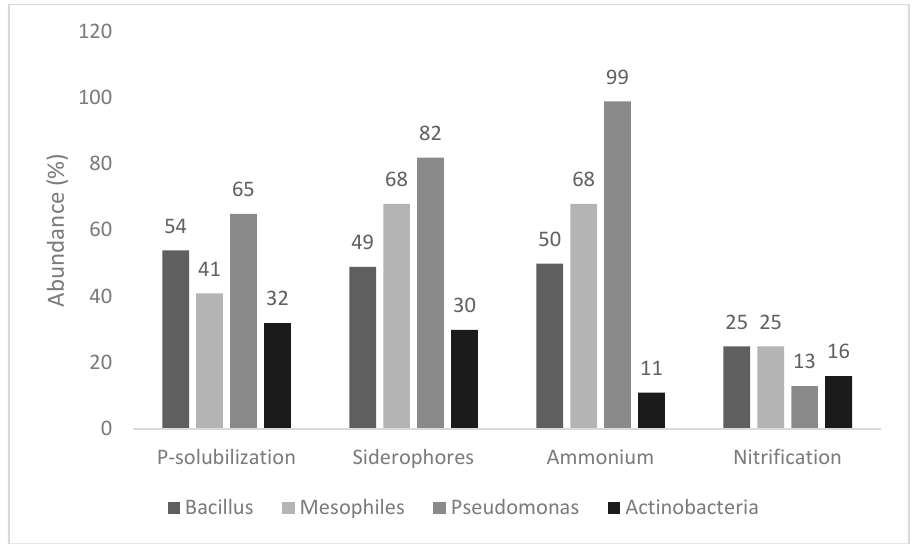
Figure 1. Strains positive to P-solubilization, siderophores’ production, ammonium production, and nitrification.